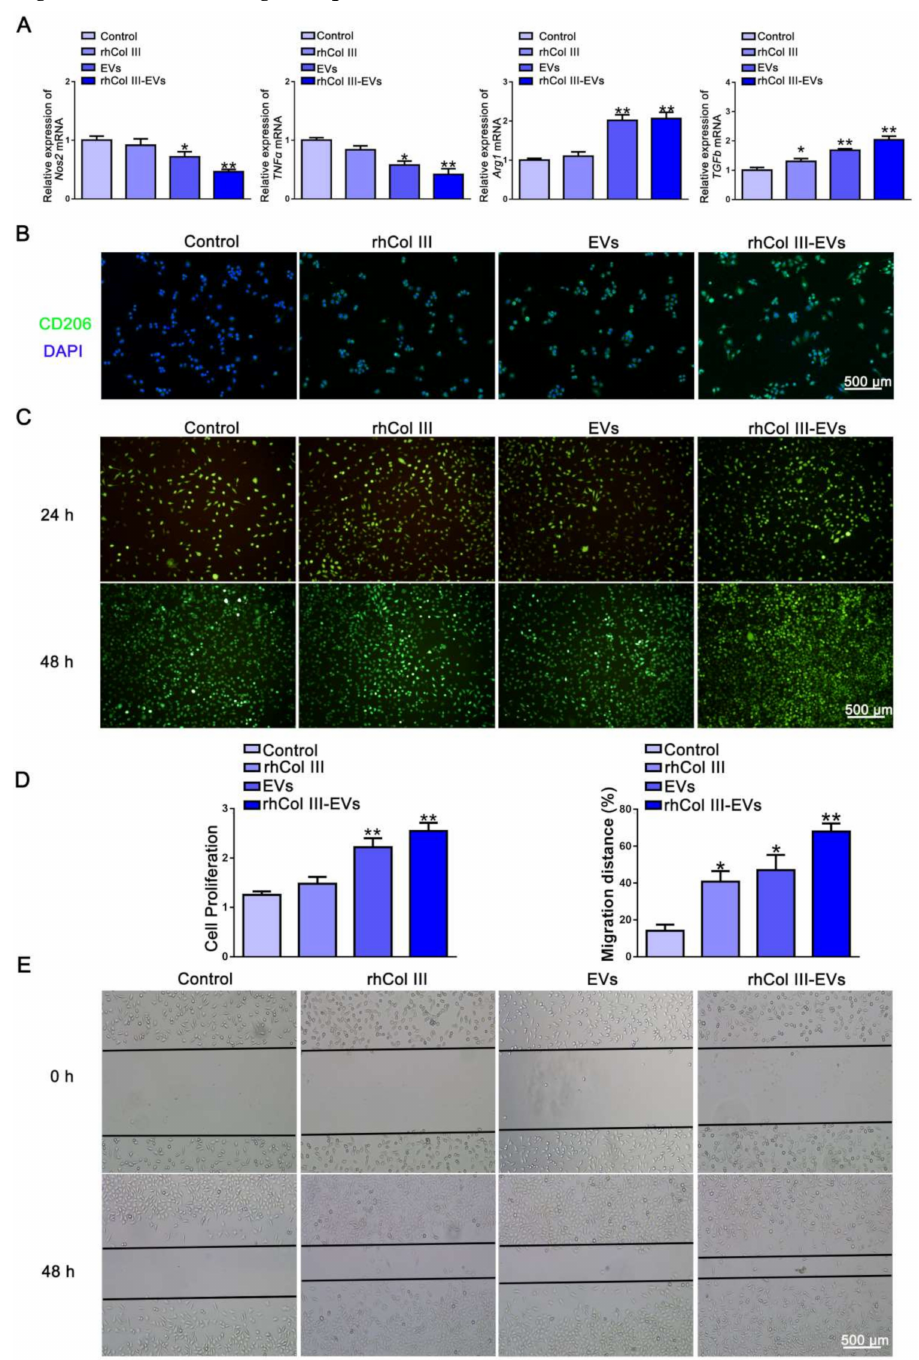
Figure 3. The differentiation of RAW264.7 cells and the migration of L929 cells. ( A ) QRT-PCR to detect the expression of M1 and M2 molecular markers in RAW264.7 cells. ( B ) Immunofluorescence (green) showing the number of CD206-positive cells in RAW264.7 cells ( n = 3). ( C ) Live/dead analysis of L929 cells in different groups ( n = 3). ( D ) Proliferation of L929 cells in different groups ( n = 3, * p -value < 0.05 vs. Control group, ** p -value < 0.01 vs. Control group). ( E ) Scratch test detected the migration ability of L929 cells ( n = 3, * p -value < 0.05 vs. Control group, ** p -value < 0.01 vs. Control